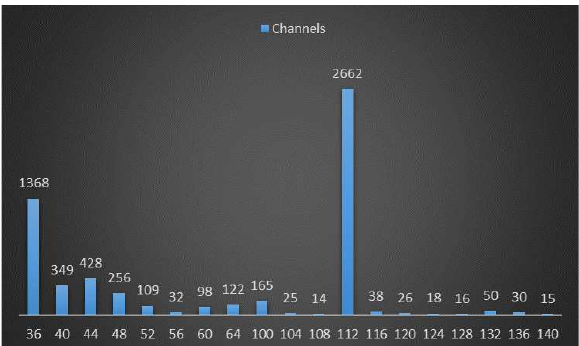
Figure 7. Channel usage in the 5 GHz band number of networks. The top 20 SSIDs are shown in Table 5.